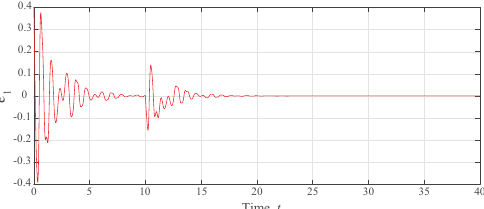
Figure 4. Time evolution of the tracking error e 1 for the proposed MRAC with parametric